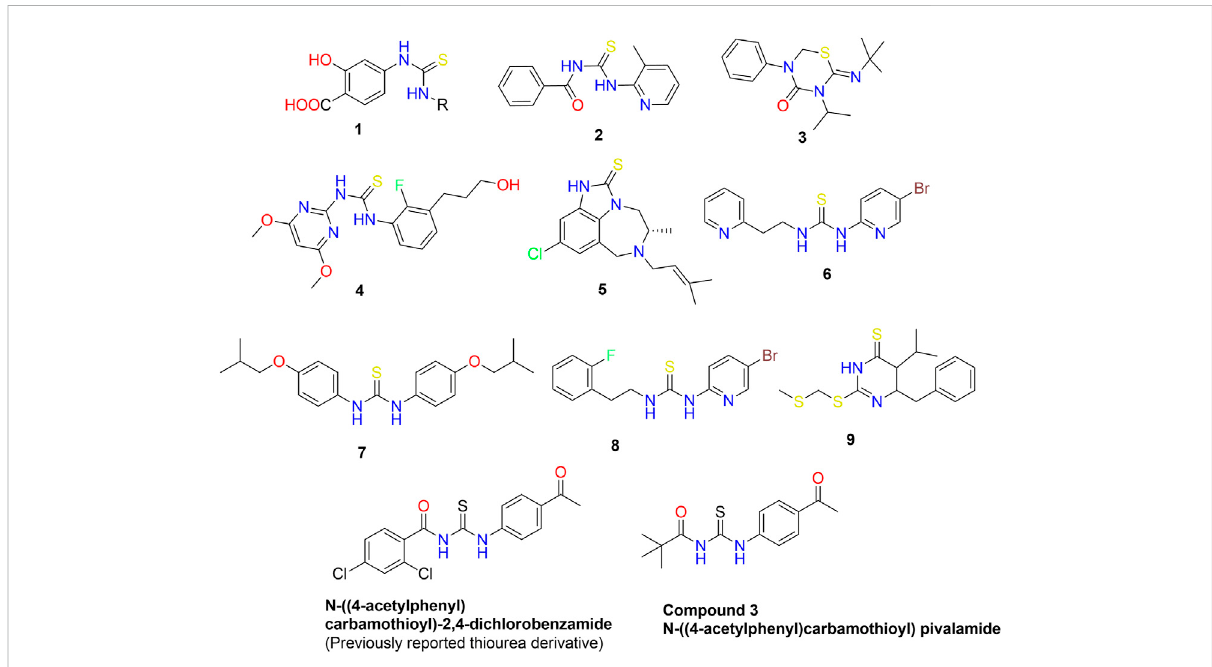
FIGURE 1 Bioactive aliphatic and cyclic thiourea derivatives 1 – 10 (Wright and Hallstrom, 2006; Saeed et al., 2017a; Saeed et al., 2017b; Larik et al.,